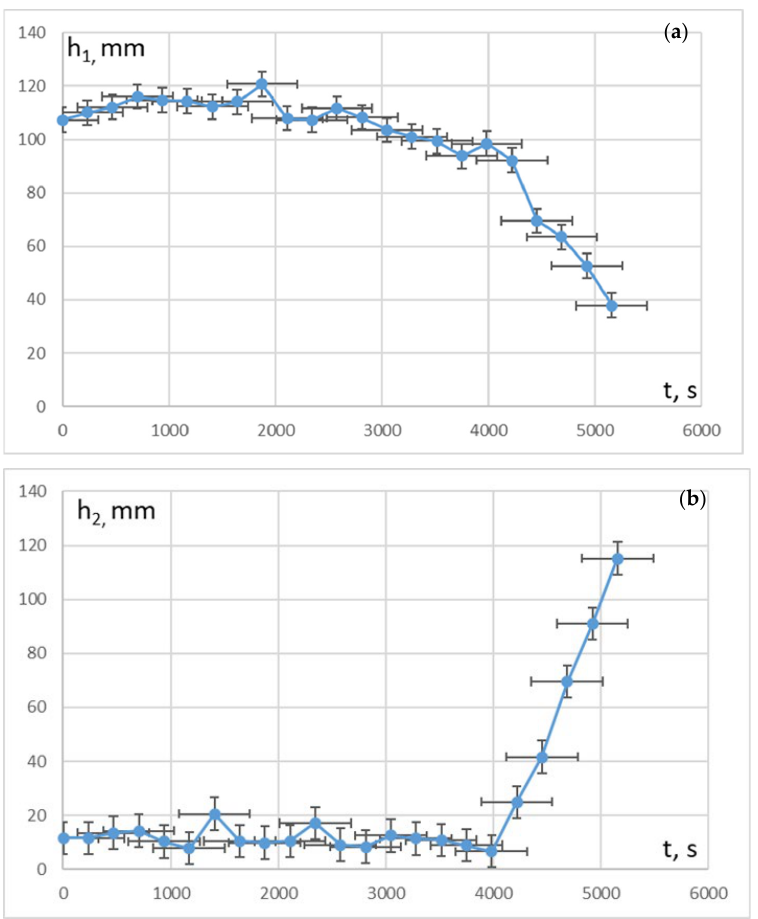
Figure 6. Variations of the sublayers thickness versus time: ( a ) the quasi-homogeneous sublayer thickness h 1 ; ( b ) the salinity interface sublayer thickness h 2 , Ri initial = 100; Re = 214. The bars display the standard deviation of the data.